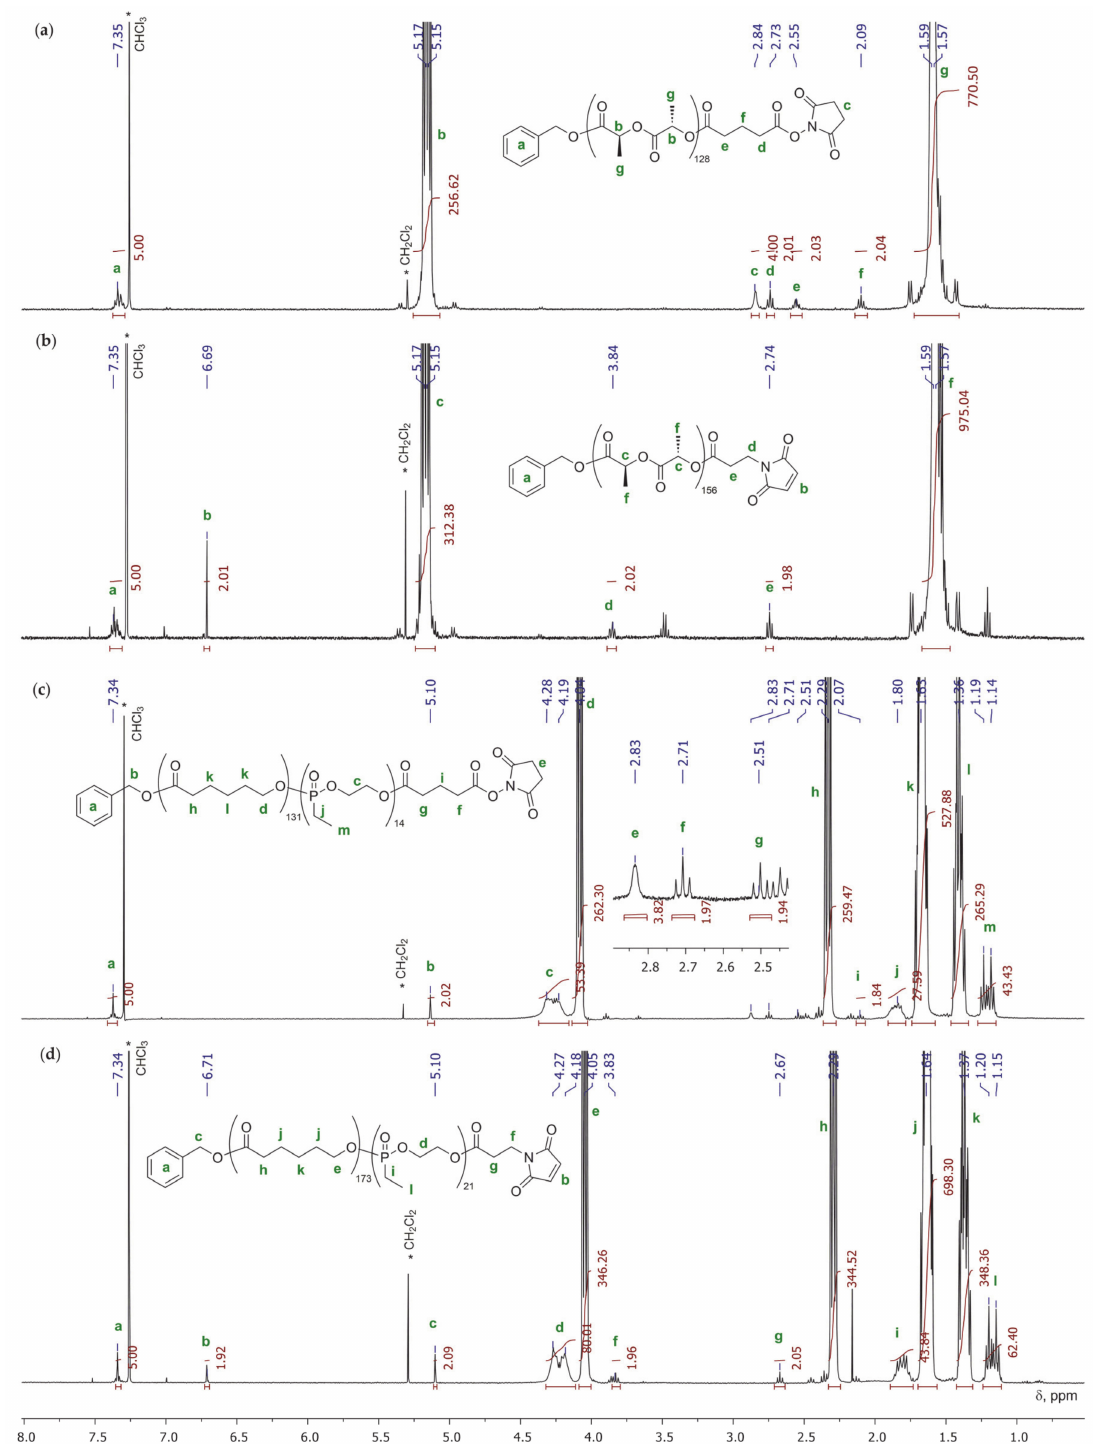
Figure 1. 1 H NMR spectra of NHS- and MI-functionalized polymers (Table 1, Entries 7 ( a ), 8 ( b ), 11 ( c ), and 12 ( d )). The signals of the protons of the fragments of functionalized polymers are marked as letters (bold and green) the solvent impurities are marked by asterisks (*). 3.2. Functionalization by the Reaction of the Polymers with Acyl Chloride 1